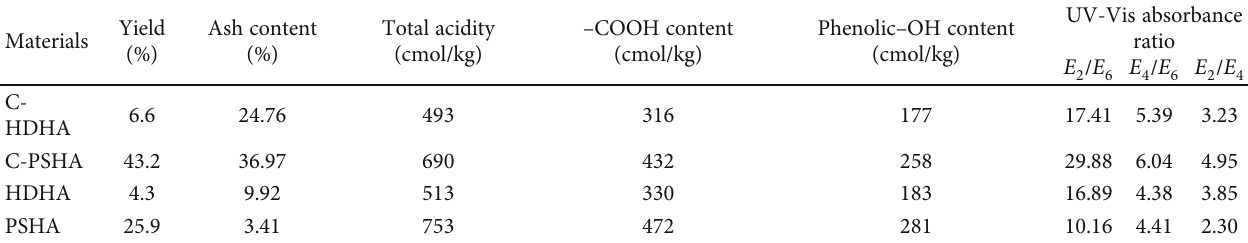
Figure 1: (a) Characteristic UV-Vis spectra of puri fi ed peat soil HA (PSHA), puri fi ed horse dung HA (HDHA), crude peat soil HA (CPSHA), and crude horse dung HA (CHDHA). (b) Characteristic functional groups of PSHA, HDHA, magnetite, and MHDHA. Table 1: Characteristic parameters (yield, ash content, total acidity, and UV-Vis absorbance ratio) of extracted C-HDHA and HDHA compared with C-PSHA and